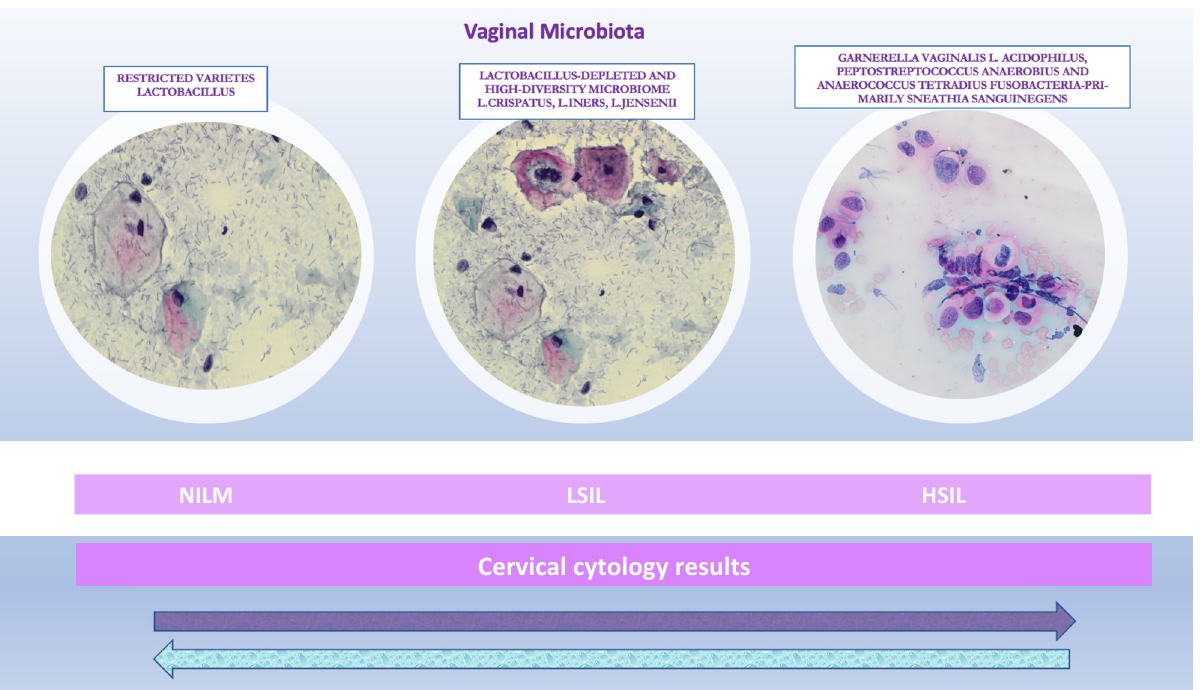
Figure 1. Cervical cytology results and corresponding cervical microbiota. The illustration is a summary chart of the uterine cervix microbiota community composition in physiological and precan- cerous stages, showing how it can influence both intraepithelial lesions progression and the stable condition of the cervical epithelium (cytological images at high magnification 40×). The arrows in- dicate the reversibility of the cervical changes: precancerous stages versus negative for intraepithelial lesion or malignancy (NILM).